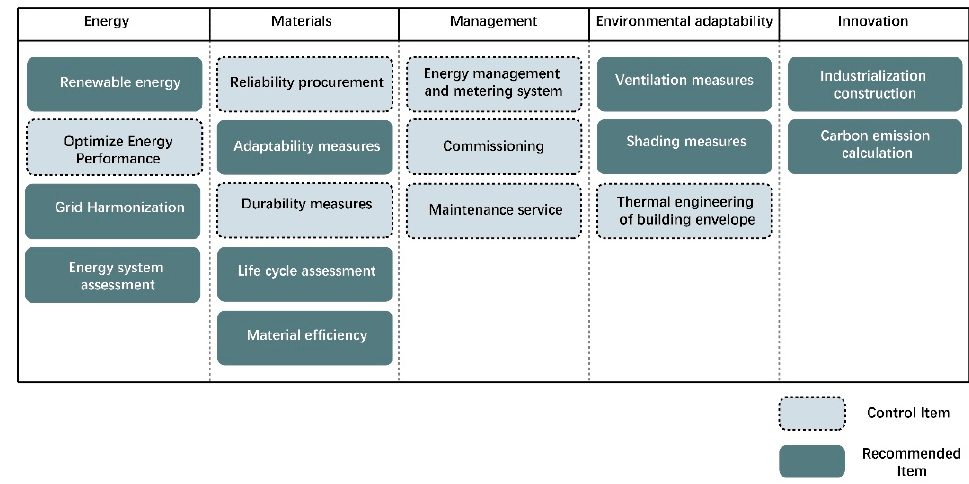
Figure 5. Control and recommended items of